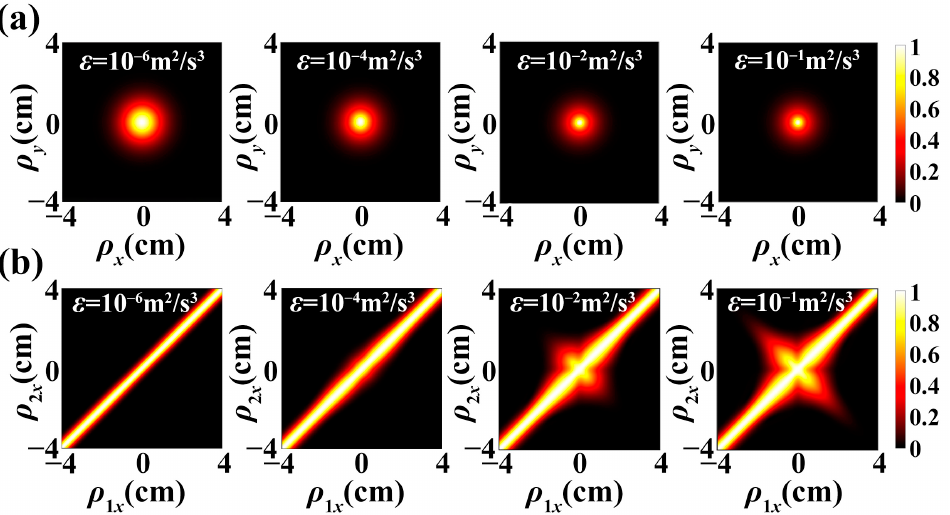
Figure 5. Density plot of ( a ) the normalized spectral intensity and ( b ) the absolute value of the spectral DOC of a LNUC beam in oceanic turbulence with different values of the dissipation rate of kinetic energy per unit mass of fluid at propagation distance z = 150 m.